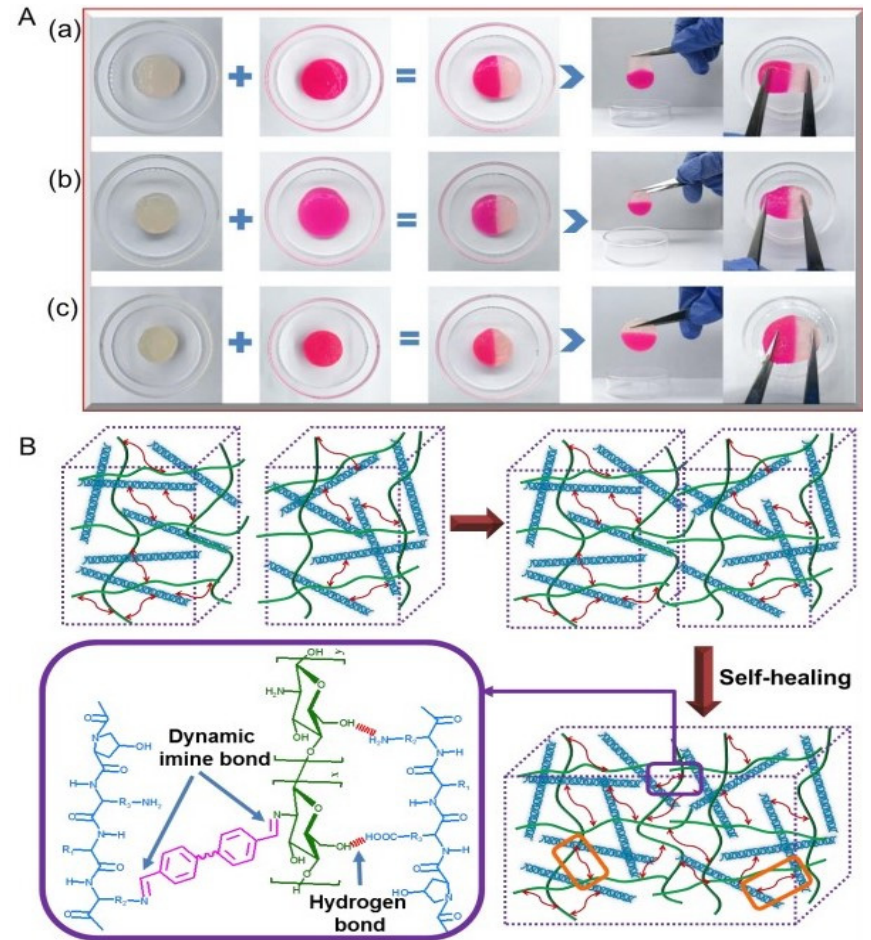
Figure 3. ( A ) Demonstration of Cut-Heal property of the hydrogel obtained from Collagen-chitosan at ratio of ( a ) 1/1, ( b ) 1/2 and ( c ) chitosan alone ( B ) Diagrammatic representation of Self-healing mechanism showing hydrogen bond and imine bond formation. (Reproduced with permission from Ref. [47]. Copyright 2020, American Chemical